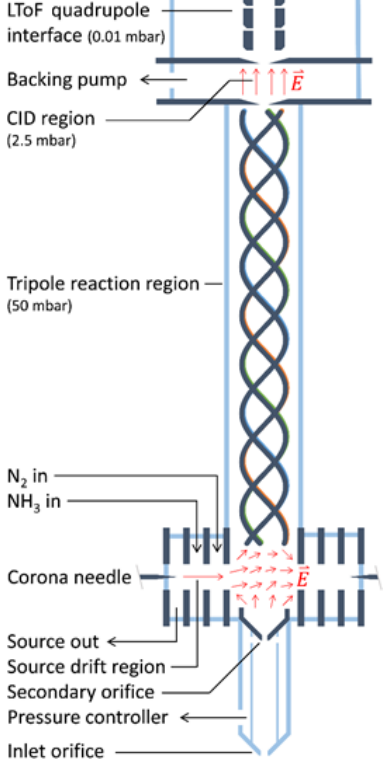
Figure 1. Schematic drawing of the NH +